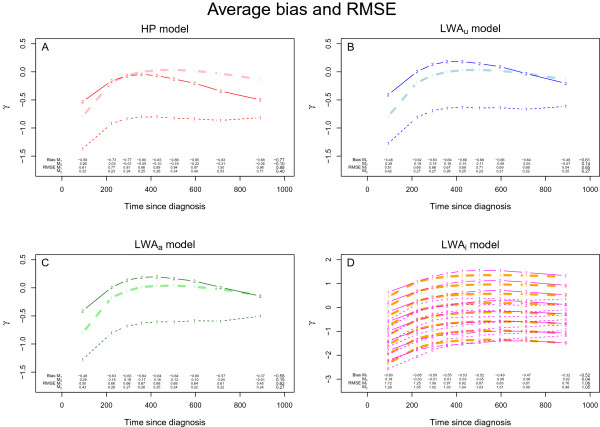
Methods and Models. Exposure effect’s estimation according to Methods 1 and 2 and related to: (A) The HP model, (B) The LWAu model, (C) The LWAa model and (D) The LWAi model. The solid thick lines red, blue and green (Figure A, B and C) respectively, represent the theoretical average of γ(t) and the solid thick orange lines (Figure D) represent the theoretical γ(t)+α′(t)Z inside each profile Z. The fine lines red, blue and green (Figure A, B and C) respectively, represent γ(t), estimated according to Methods 1 (fine dotted lines) and 2 (solid dotted lines); and the fine red lines (Figure D) represent the observed γ(t)+α′(t)Z inside each profile. The average bias and RMSE are given for each model: bl•, b••, RMSEl• and RMSE••. These results are obtained with the increasing then decreasing HR(t) configuration, without censoring and with β12′=(−0.2,−0.4,−0.8), β13=−β12 and β23=−β13.